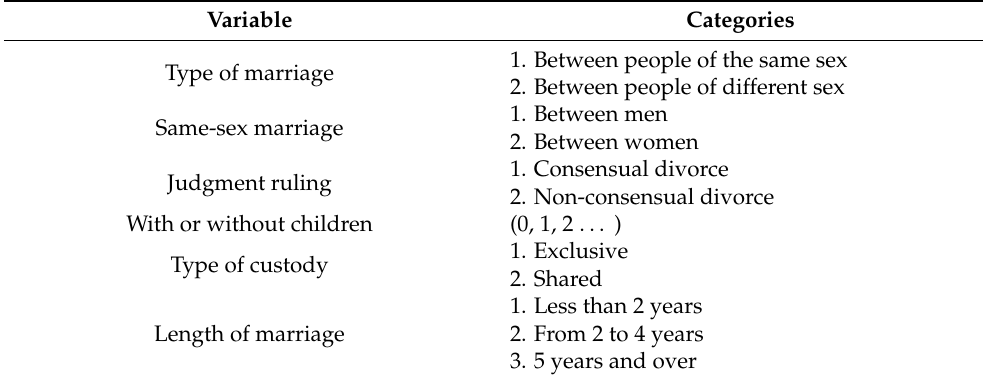
Table 1. Variables used in the